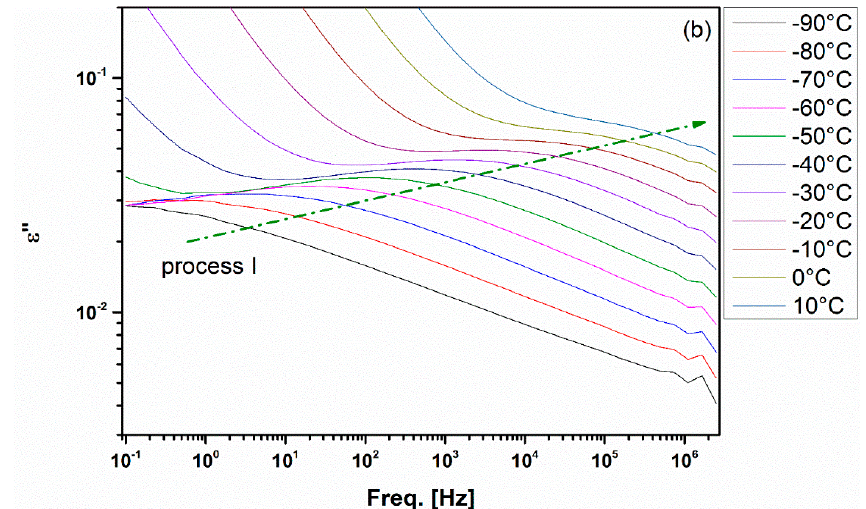
Figure 3. ε ′′ vs. f spectra for the control chitosan film ( a ) and the electrospun chitosan/PVA/AgNPs composite blend ( b ) in the low temperature range. Colored arrows follow the progress of crests of different peaks with temperature.